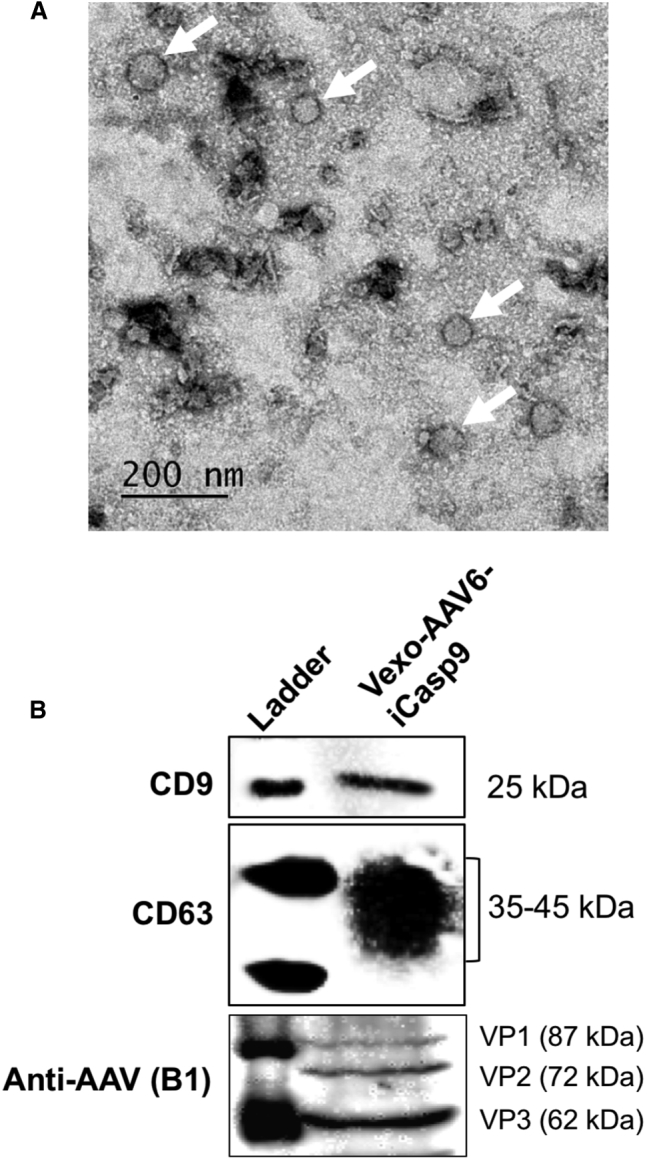
Characterization of Vexosomes Pelleted from AAV Vector-Producing AAV293 Cell-Culture Media(A) Transmission electron microscopy- The representative image shows the presence of vexosomes of varying size. Arrows show the vexosomal membrane. Scale bar, 200 nm. (B) Immunoblotting- total cell proteins were harvested and resolved on a 10% SDS-PAGE gel. Western blotting was performed to detect specific exosomal marker proteins (CD9 and CD63) or AAV capsid proteins (VP1–3). The immune-reactive bands were detected by chemiluminescence imaging. Representative images from three biological replicates are shown.